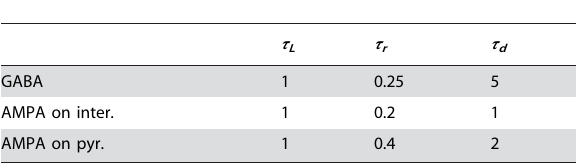
Table 4. Goodness-of-fit with experimental data of model LFP for different model parameters, measured with x 2 Methods).